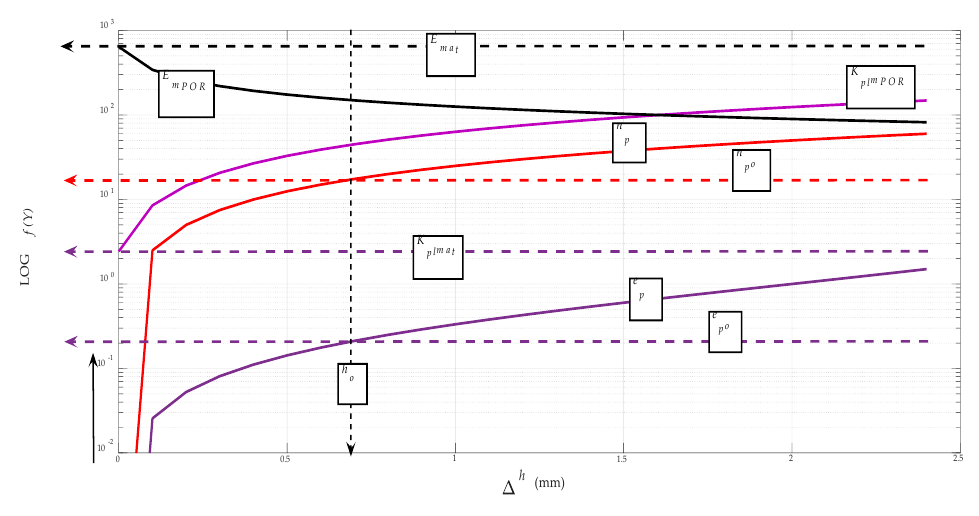
Figure 12. Porosity ( n pX ) = f (Δ h ) for Stellite.